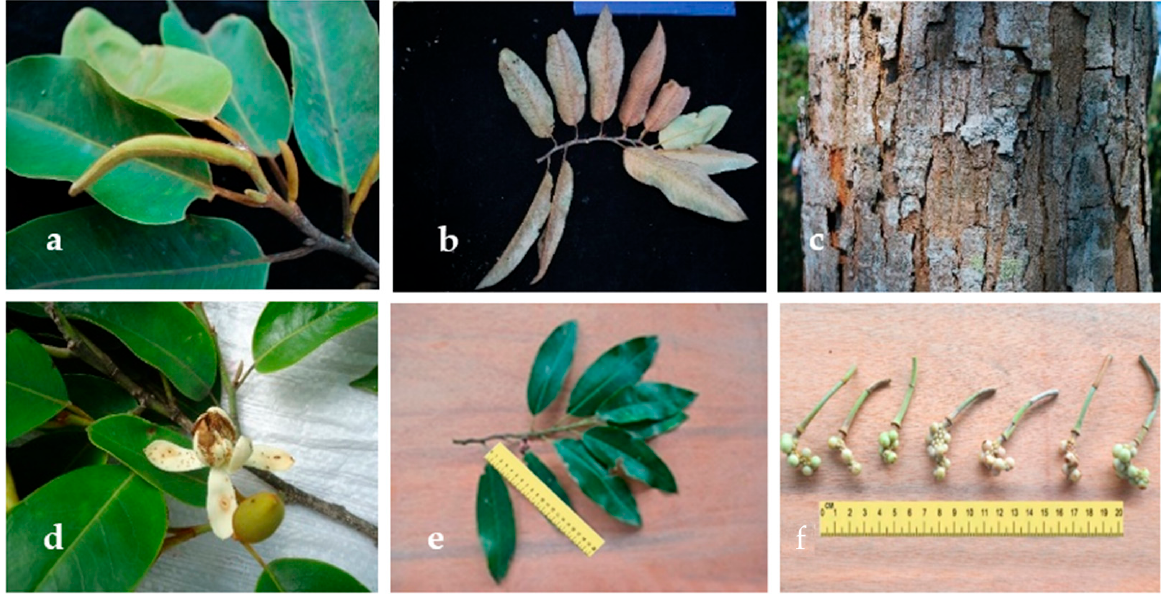
suitable habitat. In the map, the darker the color (6), the more suitable the habitat for Magnolia spp.